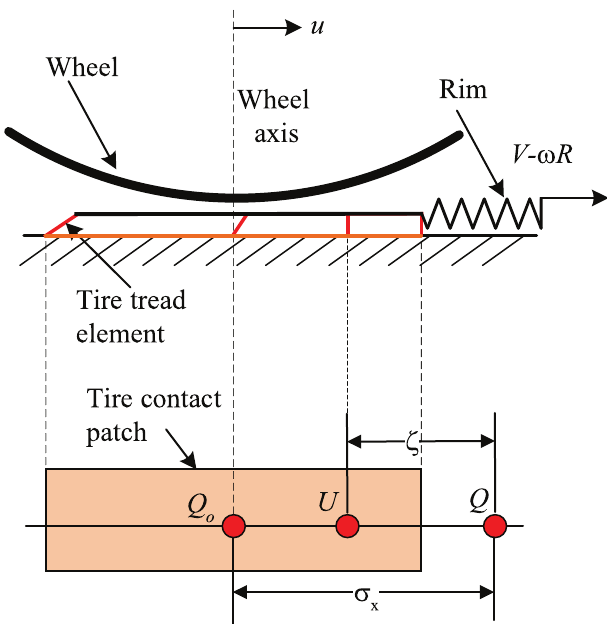
Fig. 13. Contact patch elemental deformation (adapted from [36]).